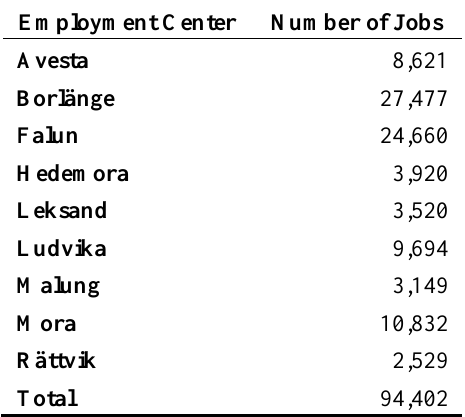
Table 3. Major employment centers. Employment Center